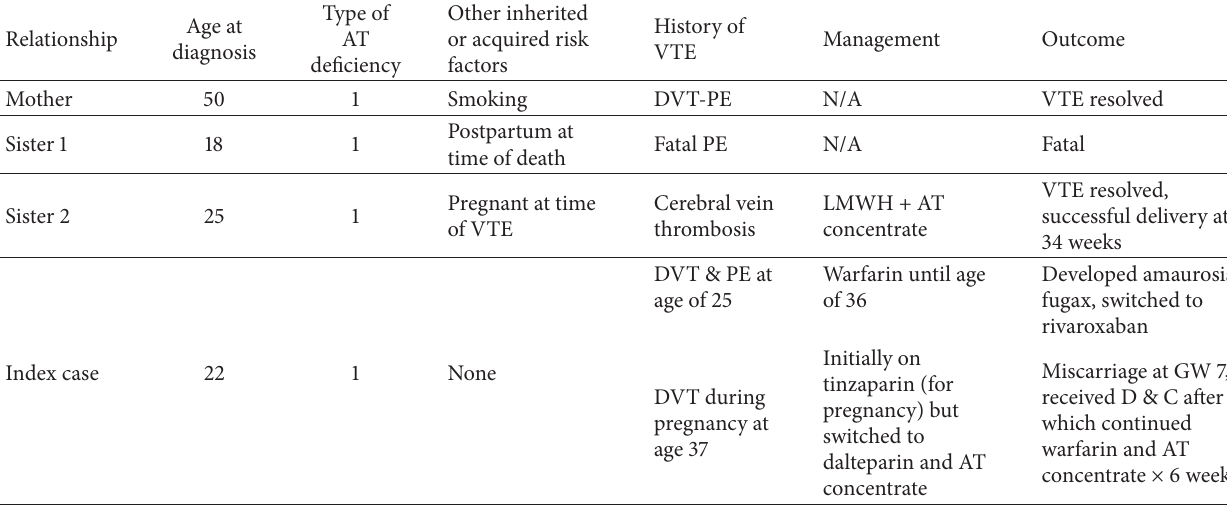
Table 1: Family History of venous thromboembolic events of the index